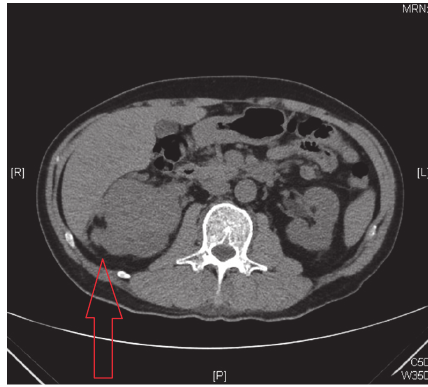
Figure 2: Focal invasion of right renal tumour into segment 6 of the liver.